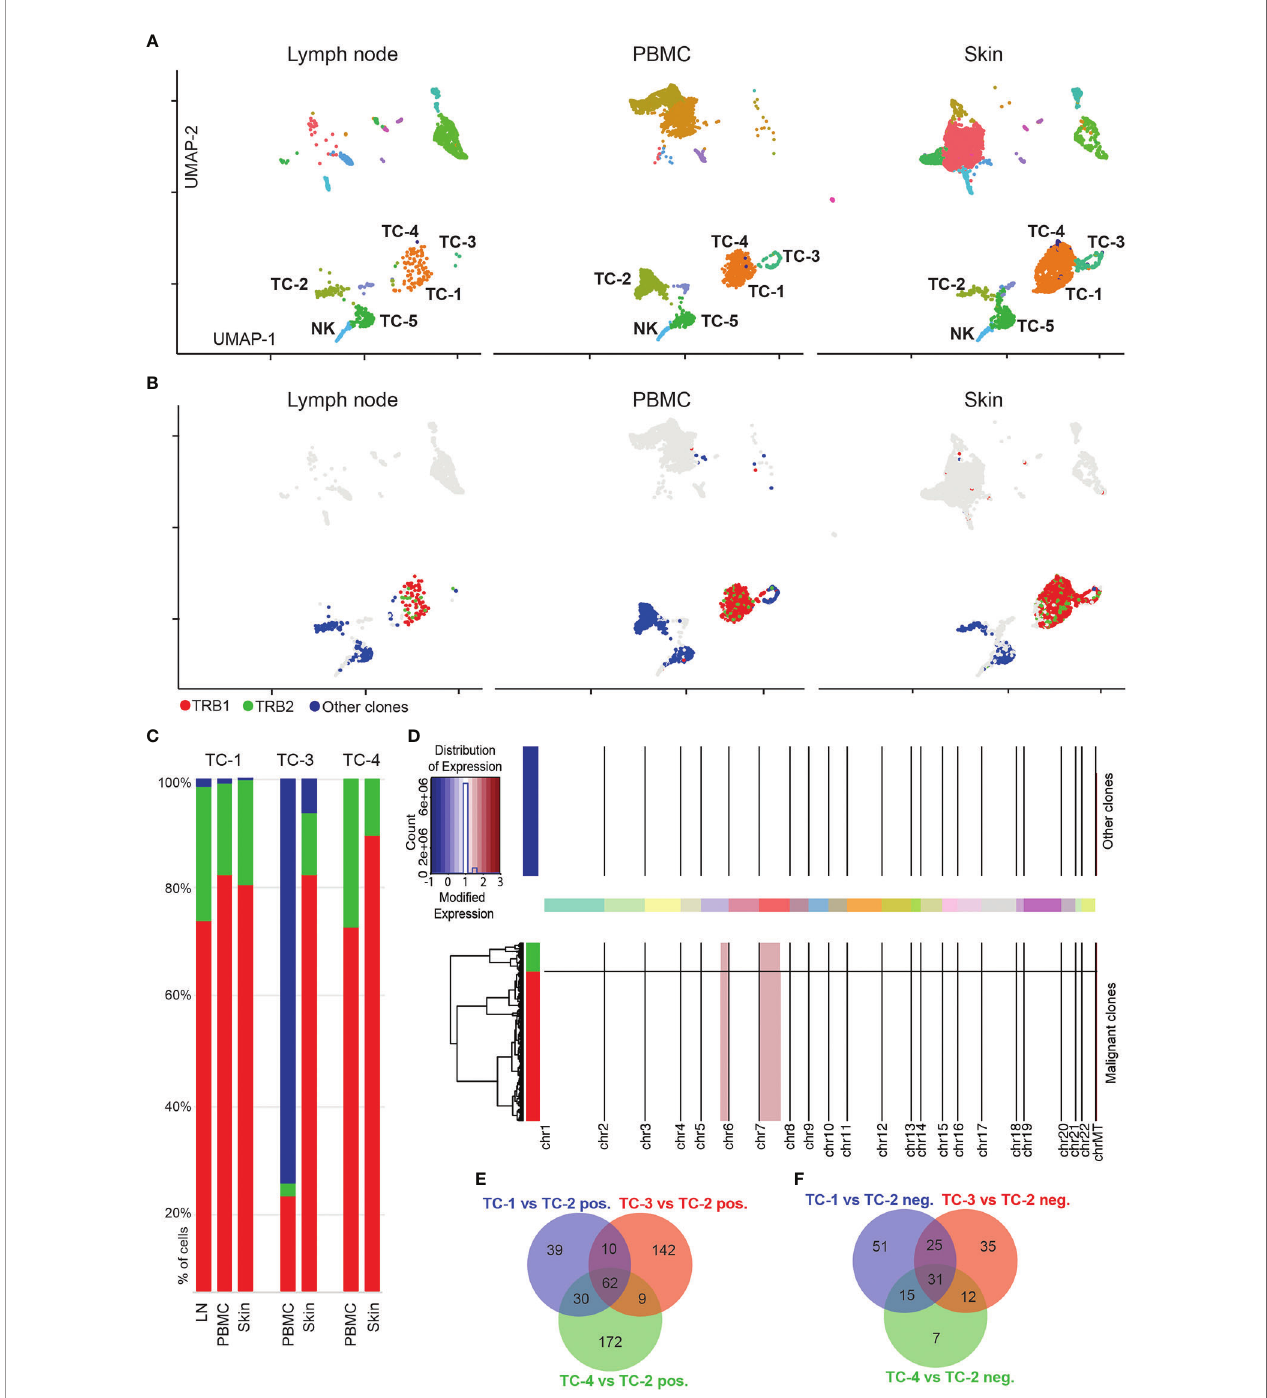
FIGURE 3 | Expansion of two similar T-cell clones in blood, lymph node and skin. (A) Separate UMAP plots of lymph node, blood and skin samples; numbers refer to respective cell clusters. (B) Cells with detectable T-cell receptor are colored; cells without detectable T-cell receptor are displayed in grey. TCR+ polyclonal cells are labelled in blue, while the two top expanded clones are labelled in red and green, respectively. Data overlaid onto UMAP plots separately for each tissue. (C) Frequencies of most common clonotypes (red, green) and the polyclonal T-cell in fi ltrate (blue) in T-cell clusters TC-1, TC-3 and TC-4. (D) Copy number variation (CNV) analysis: Chromosomes are given on x-axis, and y-axis is proportional to cell numbers. Red indicates chromosomal gains. Dendrogram legend red is clonotype TRB1 and green TRB2. (E, F) Venn diagram of signi fi cantly up- and downregulated genes comparing tumor clusters TC-1, TC-3 and TC-4 with benign CD4+ T-helper cells from cluster TC-2 (adjusted p value<0.05, logFC>|0.5|). UMAP: Uniform Manifold Approximation and Projection; PBMC: Peripheral blood mononuclear